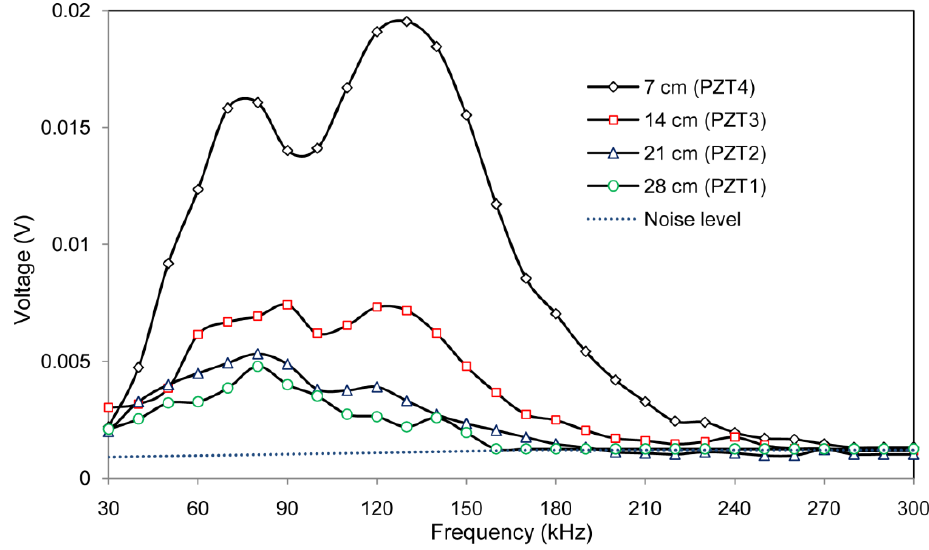
Figure 8. Maximum voltage received from PZT 1 to 4 by setting PZT 5 as